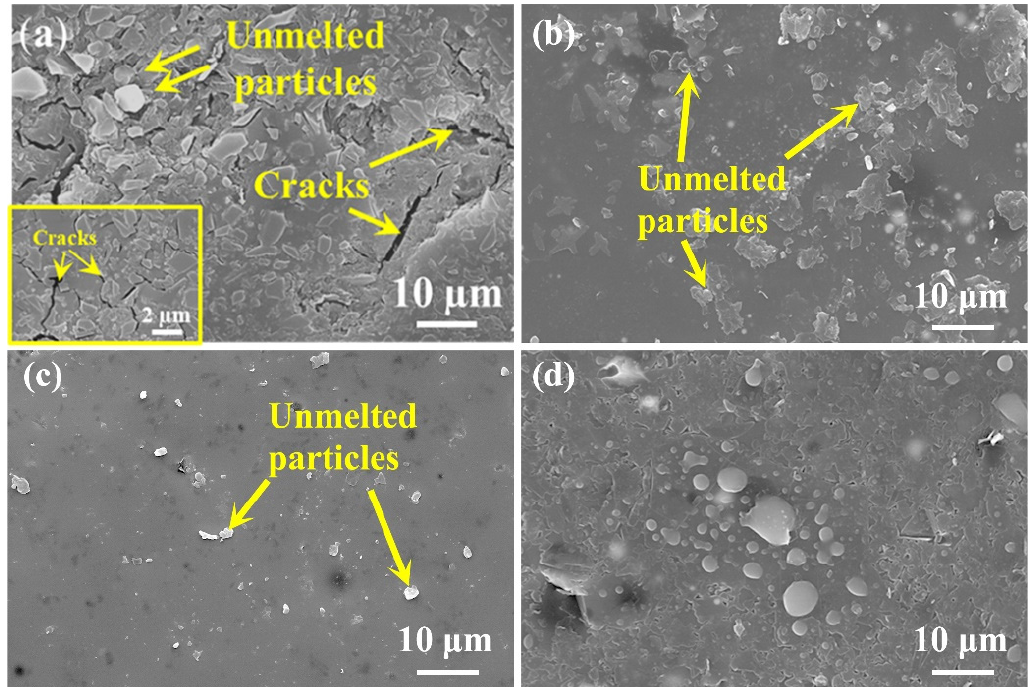
Figure 5. Surface morphologies of the PSN/lead–borosilicate glass–B 4 C coatings with different lead glass content after oxidation at 500 °C for 2 h: ( a ) Pb10; ( b ) Pb20; ( c ) Pb30; and ( d ) Pb40.